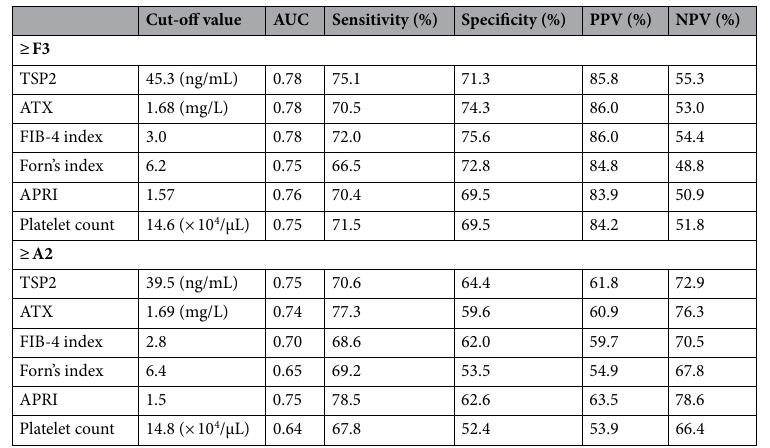
Table 3. Diagnostic performance of TSP2 and other clinical parameters for predicting advanced fibrosis stage (≥ F3) and activity grade (≥ A2) in patients with HCV in the discovery cohort. APRI aspartate aminotransferase to platelet ratio index, ATX autotaxin, AUC area under the receiver operating characteristic curve, NPV negative predictive value, PPV positive predictive value, FIB-4 index fibrosis-4 index, TSP2 thrombospondin